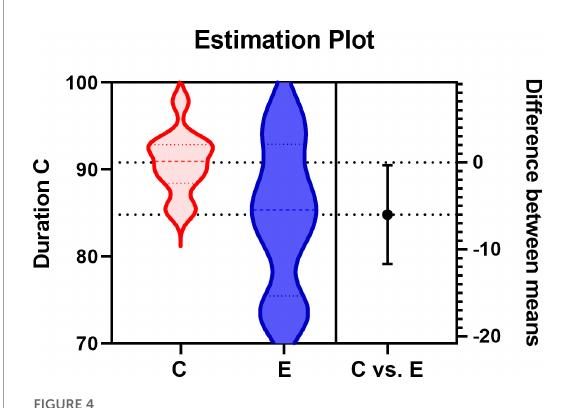
FIGURE4 Estimation Plot for the average duration of microstate C. C represents the control group (healthy group) and E represents the experimental group (patient group).